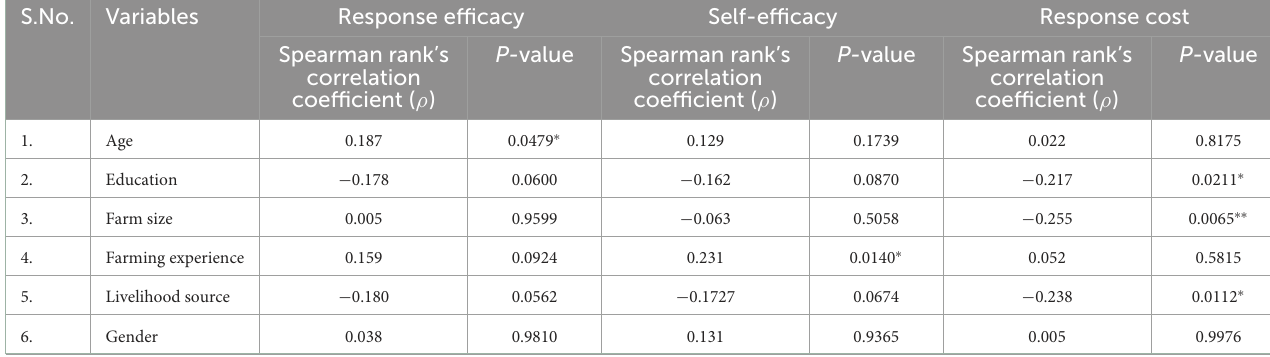
TABLE 4 Correlation between the perception of adaptation efficacy and socio-demographic characteristics.